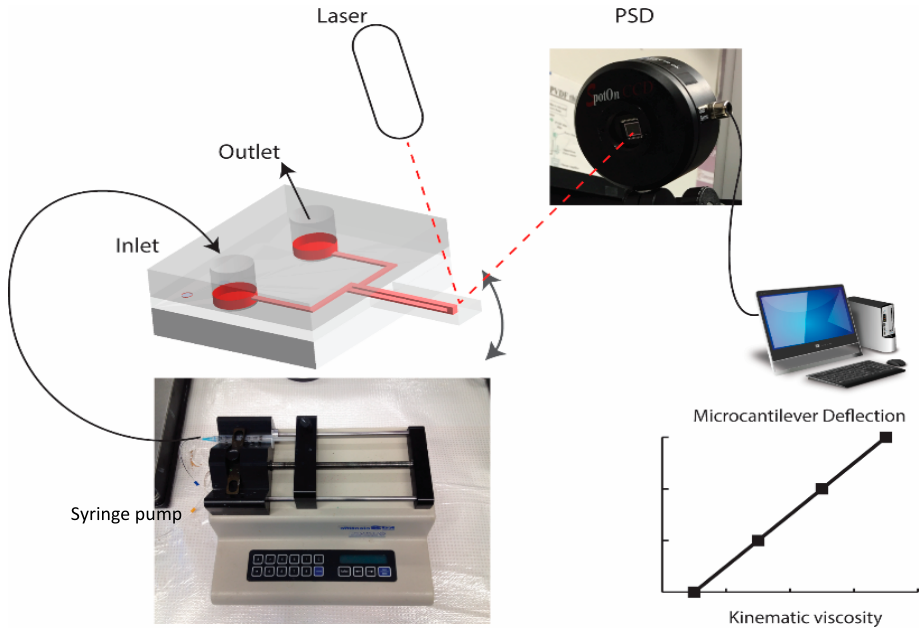
Figure 4. Laser displacement measurement system.